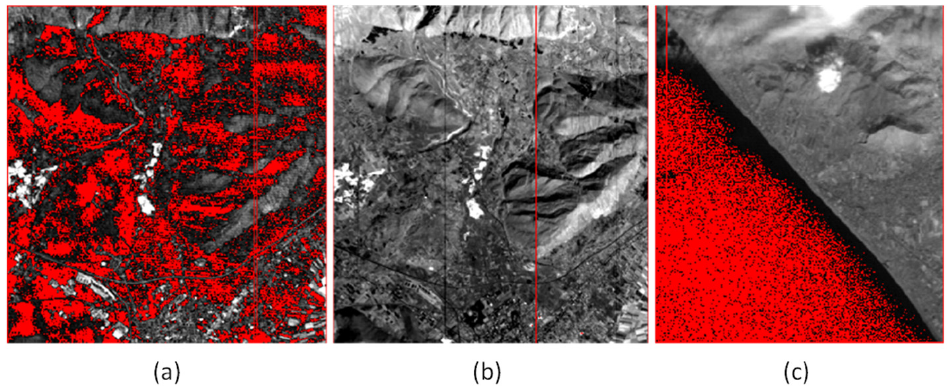
Figure 5. Bad bands images. Alba Fucens: ( a ) VNIR cube, band 2; ( b ) SWIR cube, band 27; Sinuessa and ( c ) VNIR cube, band 61. The red dots and lines represent the pixels whose values are one line all at zero or Not A Number.